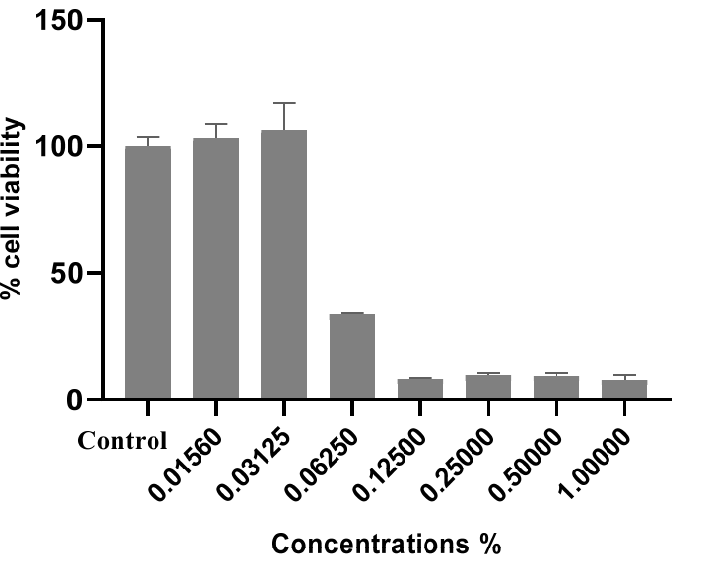
Figure 3. Cytotoxic activity of L. steochas EO against MCF-7 cells determined by MTT assay. Cells were exposed to different concentrations of EO for 24 h. All values are presented as mean ± SD.